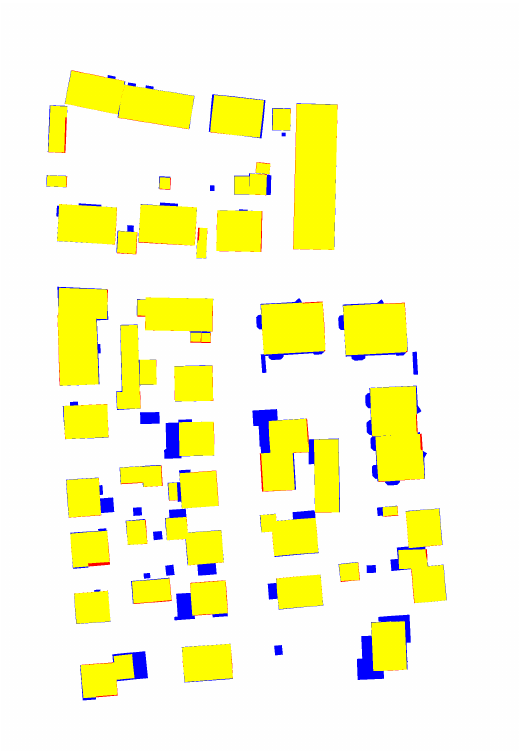
Figure 7. DSM difference between reference and